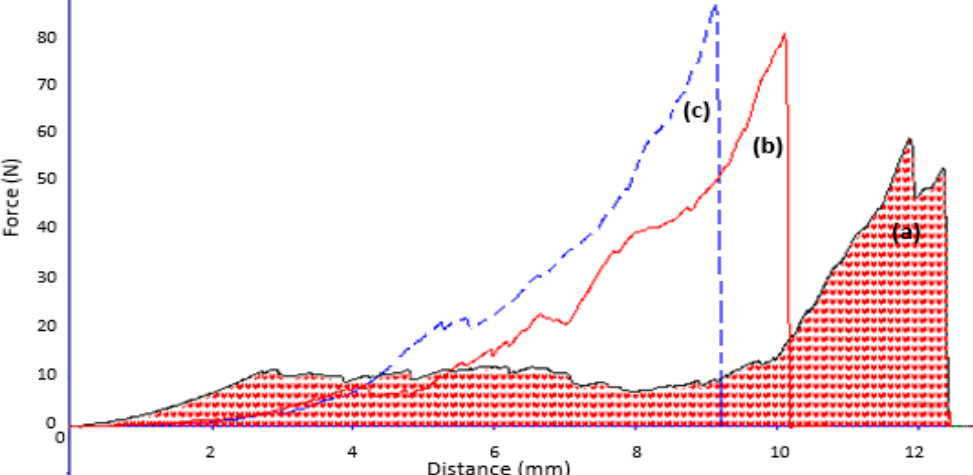
Figure 2. Characterization force-distance curve for texture analysis: fresh seeds ( a ); osmodehydrated seeds using sucrose ( b ) and sorbitol ( c ) osmotic agents.